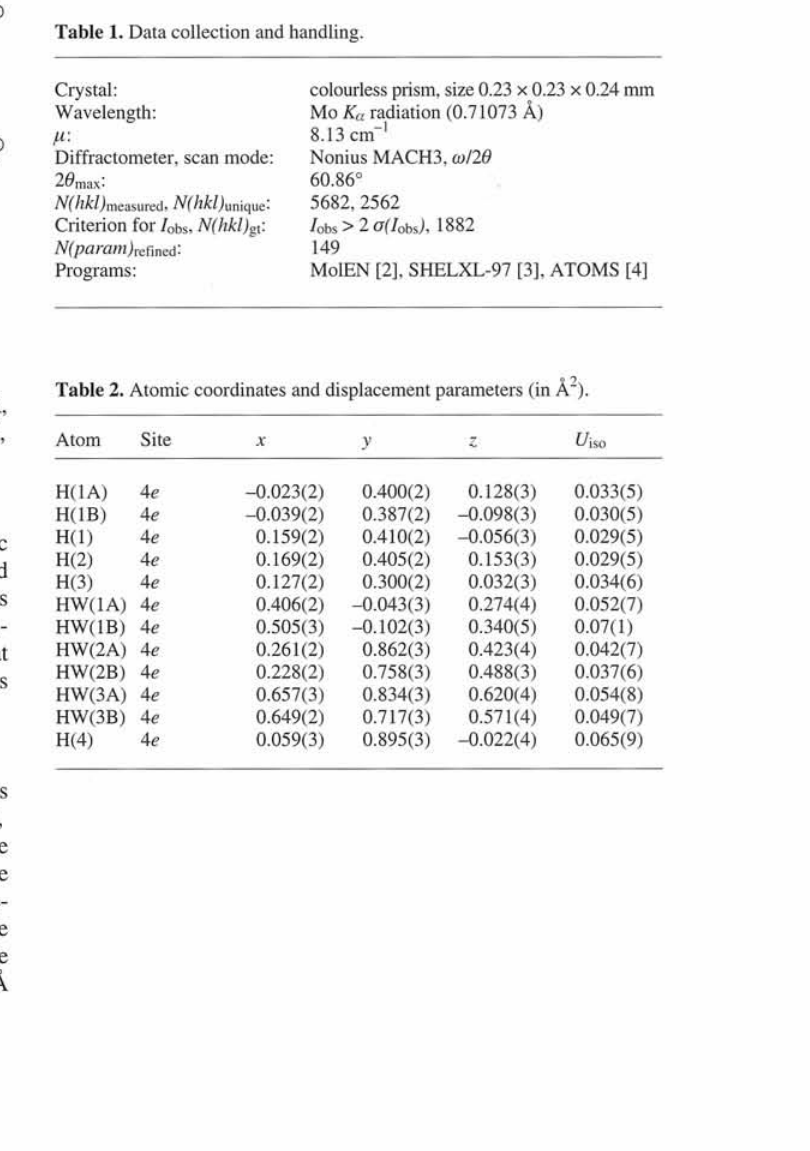
Table 1. Data collection and handling.